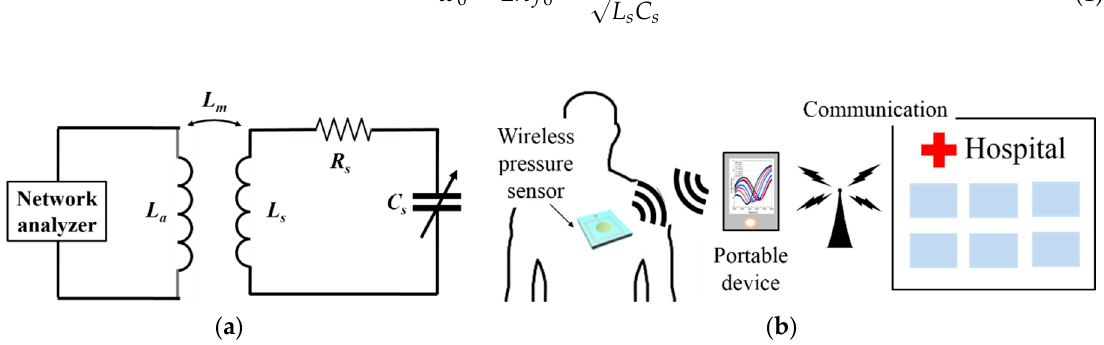
Figure 1. Schematic of ( a ) wireless and battery-less inductive-capacitive (LC) resonant circuit; ( b ) wireless blood pressure monitoring using the LC resonant sensor combined with a polymer stent.